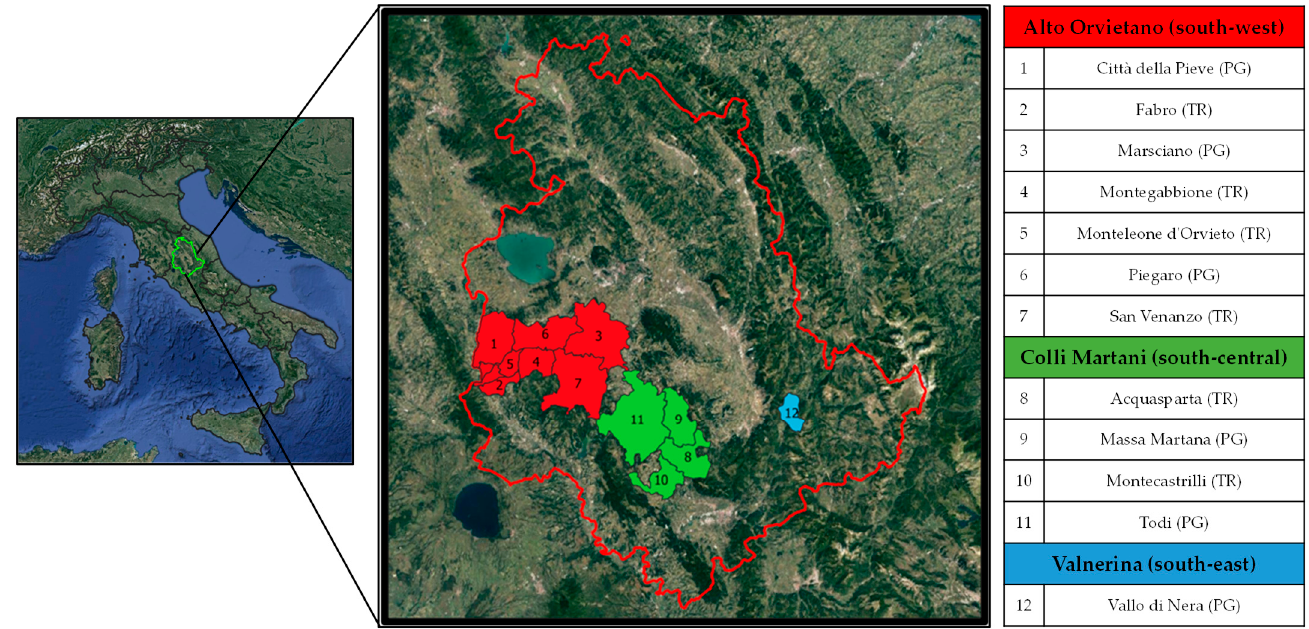
Figure 1. Geographical location and list of the 12 municipalities of Southern Umbria where the 70 grapevine samples included in the study were recovered. The color refers to the three territories considered: Alto Orvietano (in red), Colli Martani (in green), and Valnerina (in light blue). In brackets: abbreviation of the two provinces of Umbria, PG = Perugia; TR = Terni.